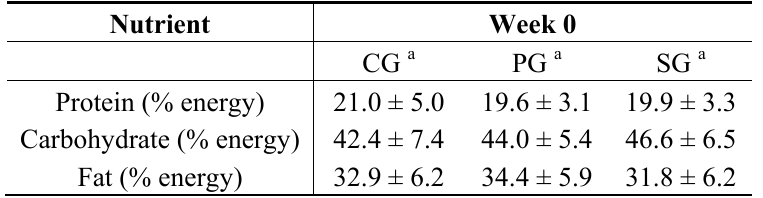
Table 2. Protein, fat and carbohydrate intake (% energy) in the control (CG), pork diet (PG) and iron supplement (SG) groups at week 0.